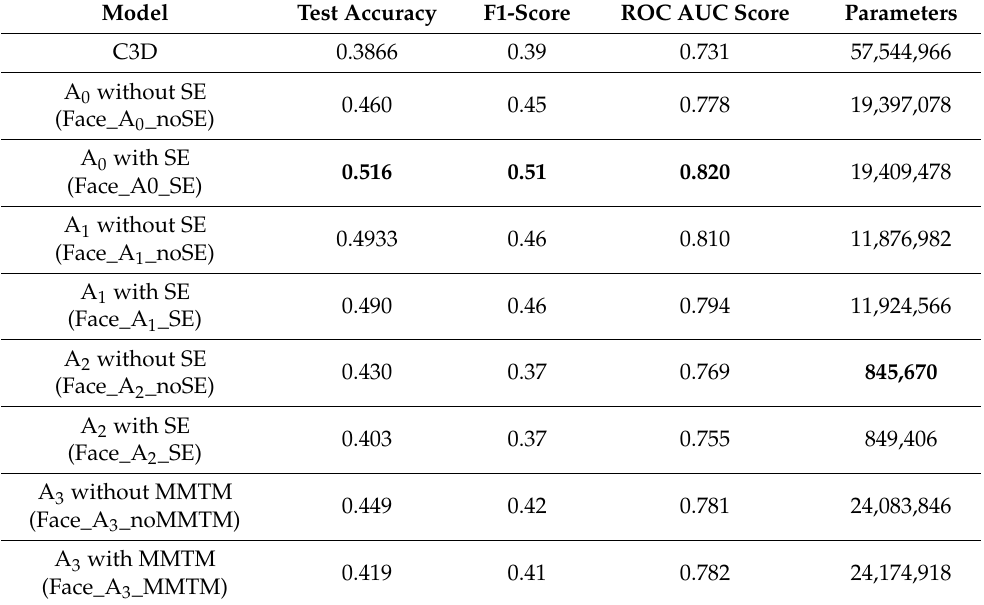
The bold number represents the highest evaluation score and lightweight network architecture (rightmost